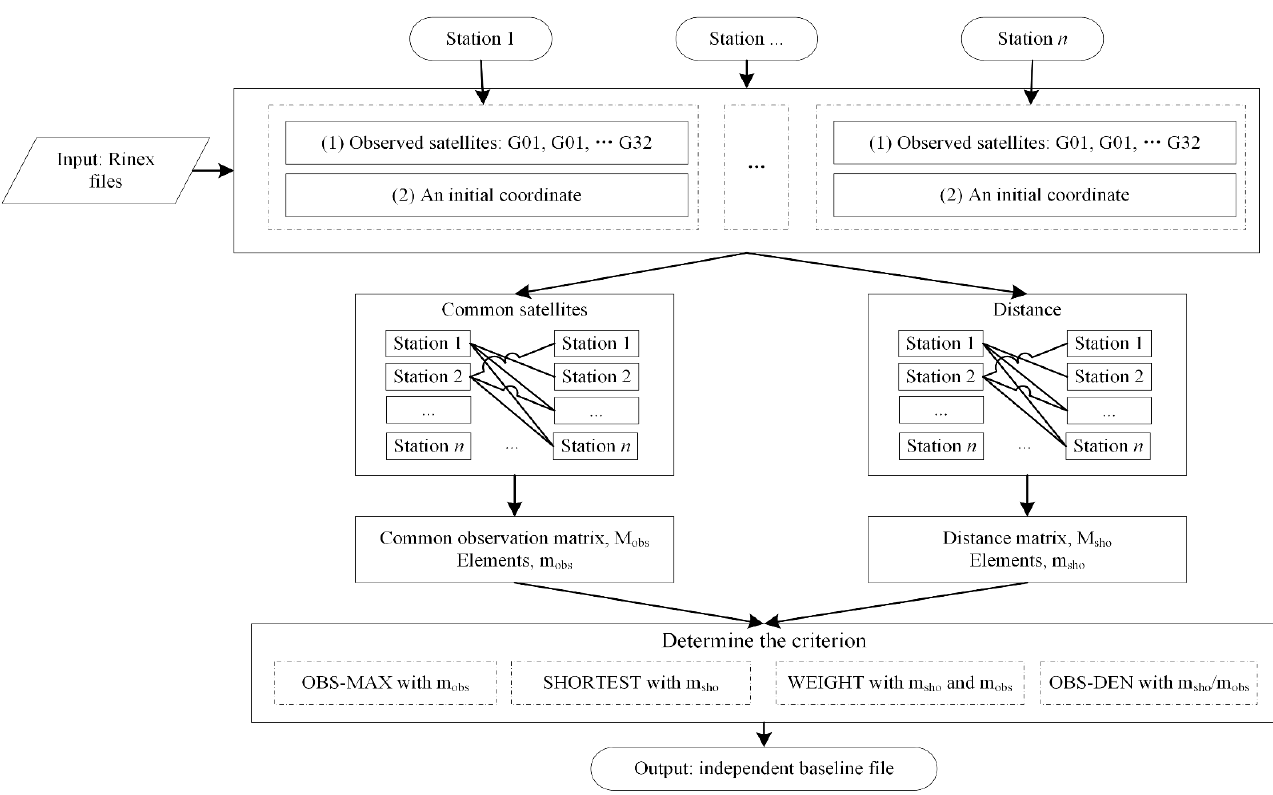
Figure 2. Flow chart for independent baseline selection, starting from reading the RINEX files of all stations, to generate different independent baseline files according to different baseline